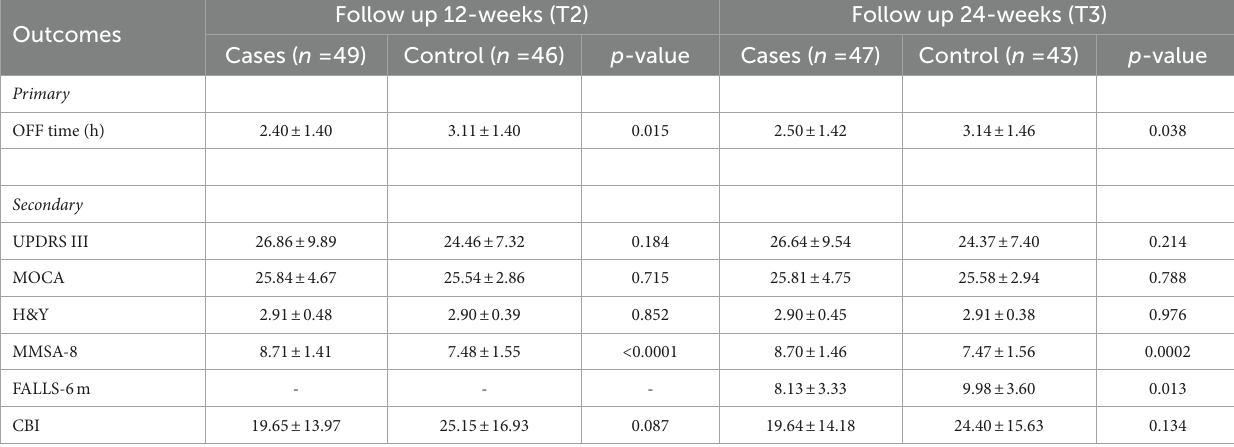
TABLE 4 Twelve-weeks (T2) and 24-weeks (T3) follow-up outcome measures for all participants and comparison between groups. Follow up 12-weeks (T2) Follow up 24-weeks (T3) Outcomes Cases ( n = 49) Control ( n = 46) p -value Cases ( n = 47) Control ( n = 43) p